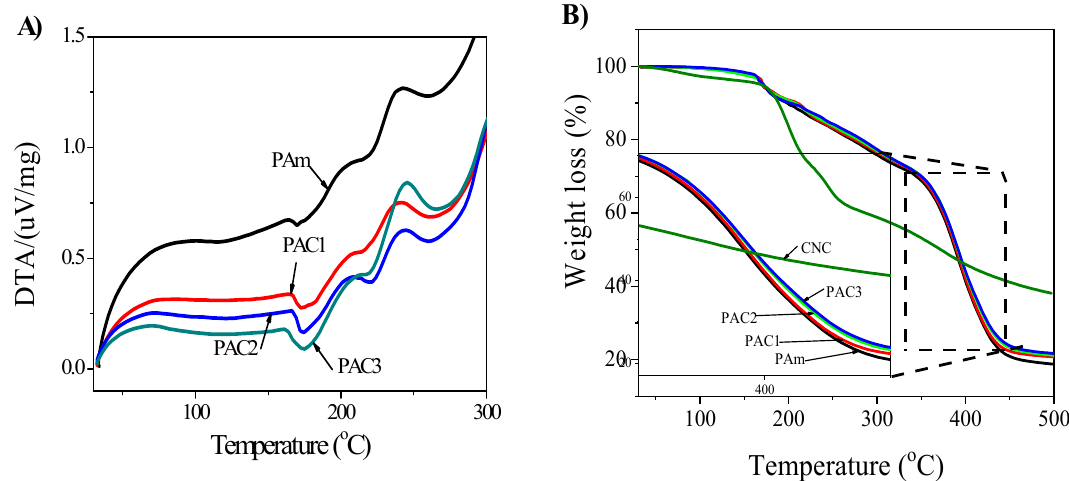
Figure 6. ( A ) Differential thermal analysis (DTA) analysis of PAm and PAC hydrogels; ( B ) TGA analysis of CNC, Pam, and PAC hydrogels.